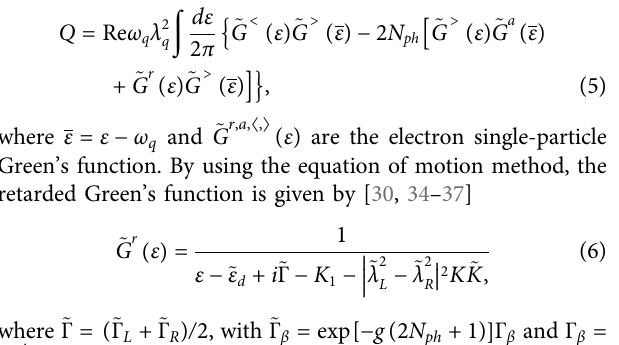
Frontiers in Physics |